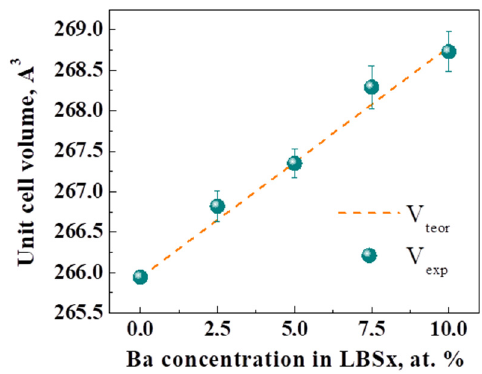
Figure 2. Unit cell volume of La 1-x Ba x ScO 3- δ samples.